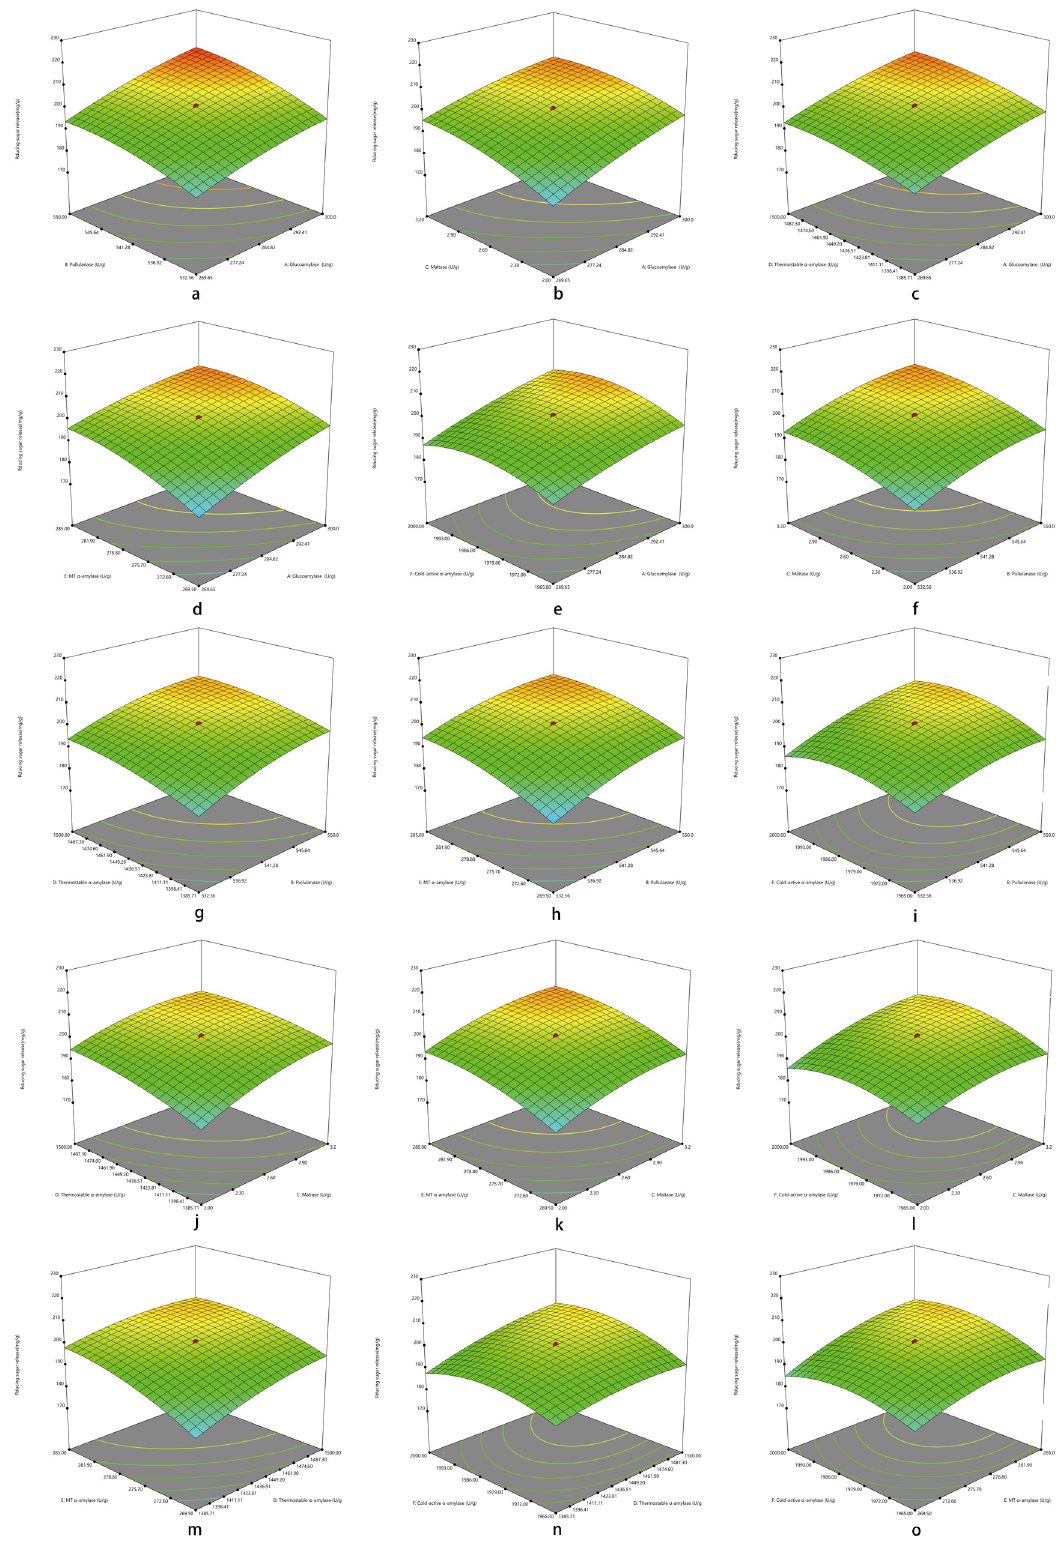
Fig 1. Respond surface plots for the significant interactions of exogenous carborhydrases on the RSA in diets for broilers aged 1 to 3 wk. (a) to (o) representing interactions of AB, AC, AD, AE, AF, BC, BD, BE, BF, CD, CE, CF, DE, DF, and EF, respectively.